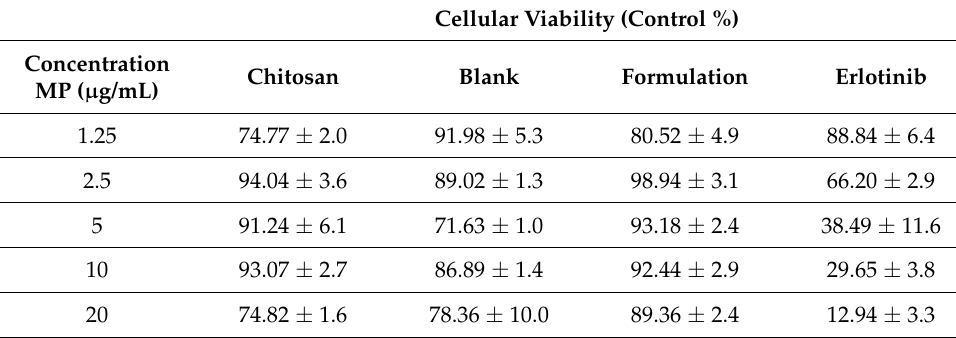
Table 10. Microcapsules